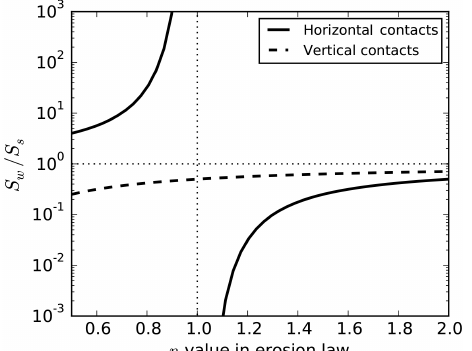
Figure 3. Channel slope response at a subhorizontal contact from an assumption of continuity. The ratio of slope within the weaker rock ( S w ) and the slope within the stronger rock ( S s ) near a hori- zontal contact (solid line) with differing values of the exponent n in the stream power model. Erodibility in the weaker rocks ( K w ) is twice that of the stronger rocks ( K s ). This subhorizontal case ap- plies when the dip of the contact is small compared to channel slope. The dashed line displays the standard topographic equilibrium re- lationship, which applies for cases where the contact slope is much larger than the channel slope.